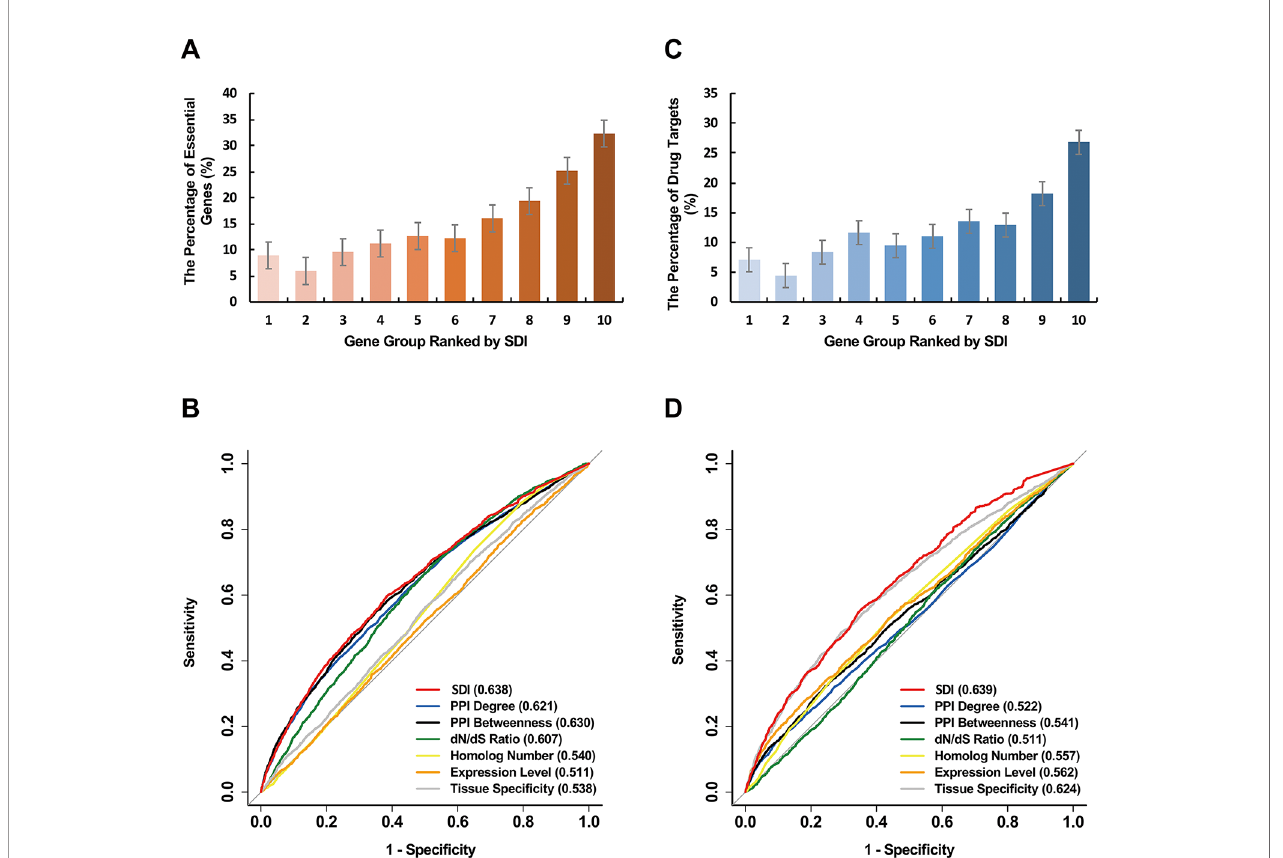
FIGURE 3 | Validation of SDI in human essential genes. The human genes were equally divided into ten groups ranked by SDI. The number of the human essential genes (A) , and the human drug targets (C) are shown in the bar graphs. The ROC curves show the results from sensitivity tests for validating the human essential genes (B) and the human drug targets (D) . The sensitivity tests were performed on 11,355 genes. The AUC scores are presented in the brackets. SDI, Subcellular Diversity Index; ROC, receiver operating characteristic; AUC, Area Under